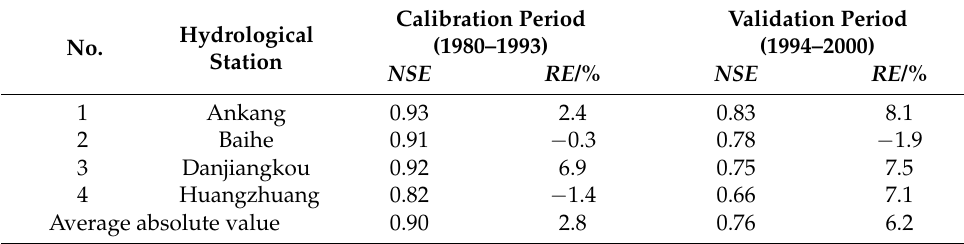
Figure 6. The observed and SWAT-simulated monthly streamflow for the calibration period (1980–1993) and for the validation period (1994–2000) in the Han River basin, China. Table 7. The calibration and validation results of the SWAT